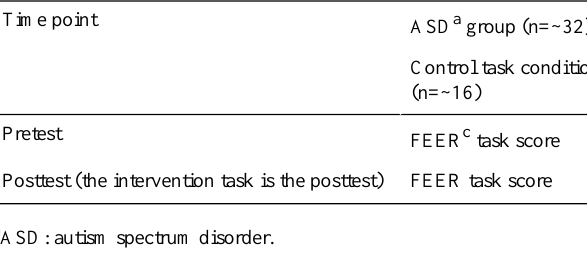
Table 2. Experimental group and intervention design.